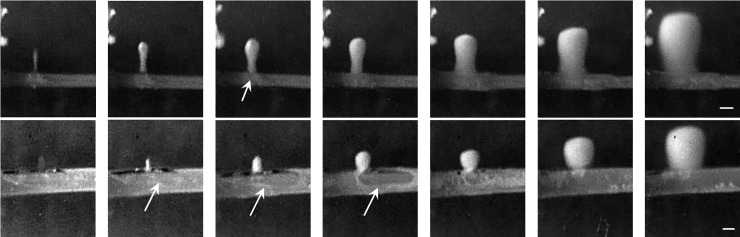
Representative images of lesion growth in a polyacrylamide gel phantom with 7% BSA after 100 s HIFU exposure at the peak negative pressure of -11.9 MPa, duty cycle of 20%, pulse repetition frequency of 10 Hz close to (a) tubing 1 and (b) tubing 2 with the circulating degassed water at the average flow speed of 267 m/s and 17 m/s, respectively. Arrows show bubbles accumulated inside the tubing during HIFU ablation. The scale bars present 2 mm.